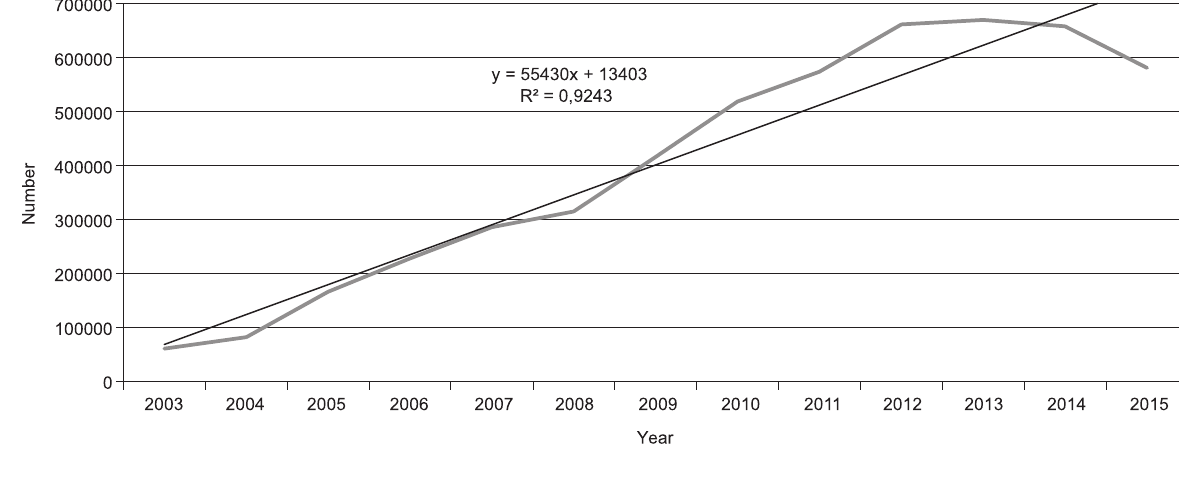
Fig. 6. Agricultural land in organic production in Poland, 2003–2015 (ha). Source: own calculations based on the IJhArS